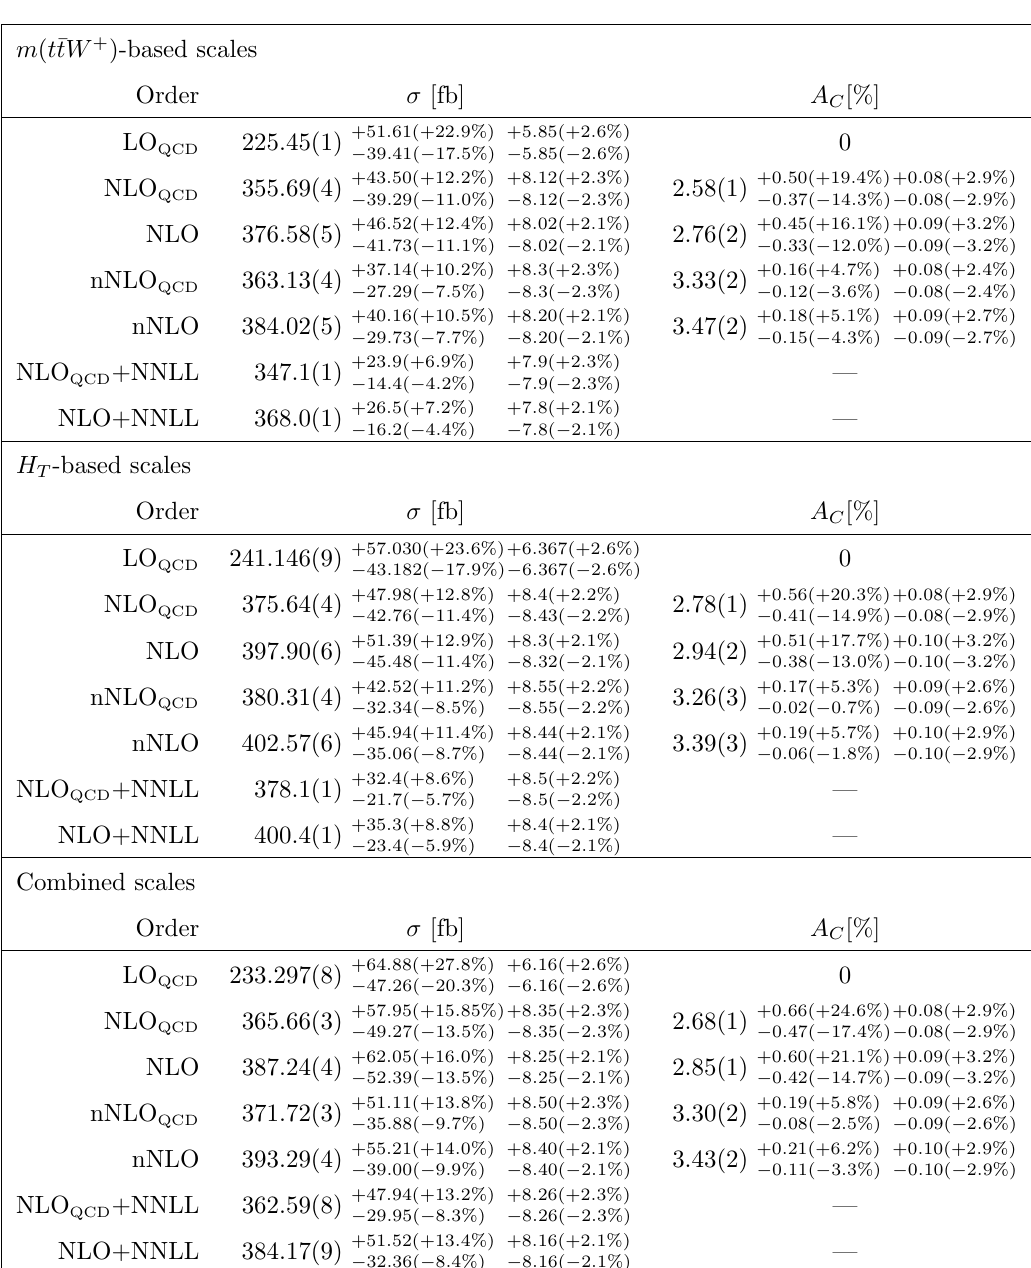
| Table 1 . Cross section and charge asymmetry for t (cid:22) tW + production for the 13 TeV LHC at various accuracies. The top portion of the table corresponds to scales based on m ( t (cid:22) tW + ), the middle portion on H T . The lower part contains predictions based on the combination of the results for the two scale choices. The (cid:12)rst number in brackets corresponds to the statistical uncertainty in the Monte Carlo integration. The (cid:12)rst number in the subscript/superscript is the uncertainty due to scale variations (the number in the bracket is the uncertainty expressed as a percentage of the central value). The last number in the subscript/superscript is the PDF uncertainty.